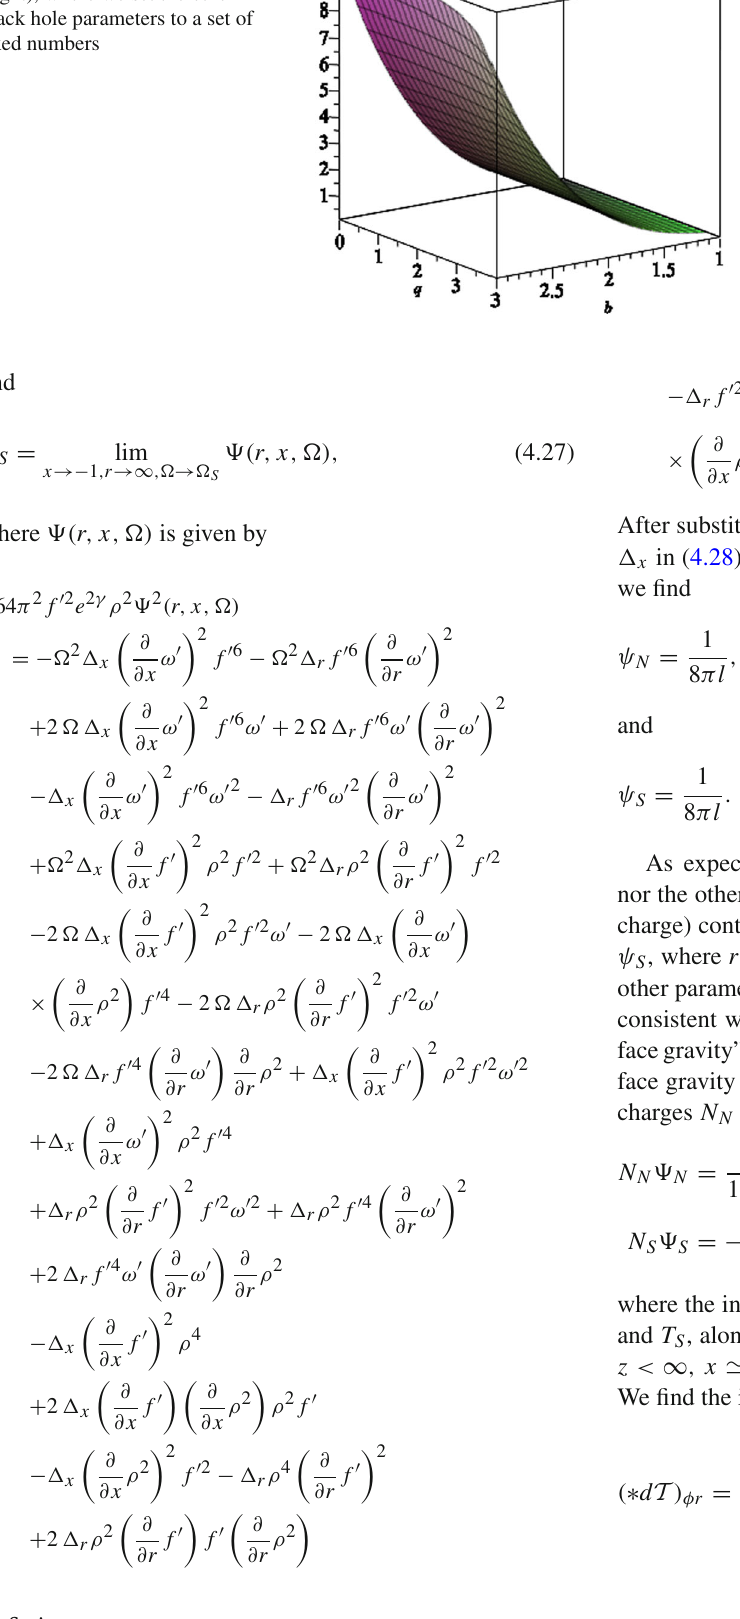
Fig. 17 The angular momentum of the black hole as function of q , b (left) and m , l (right), where we set the other black hole parameters to a set